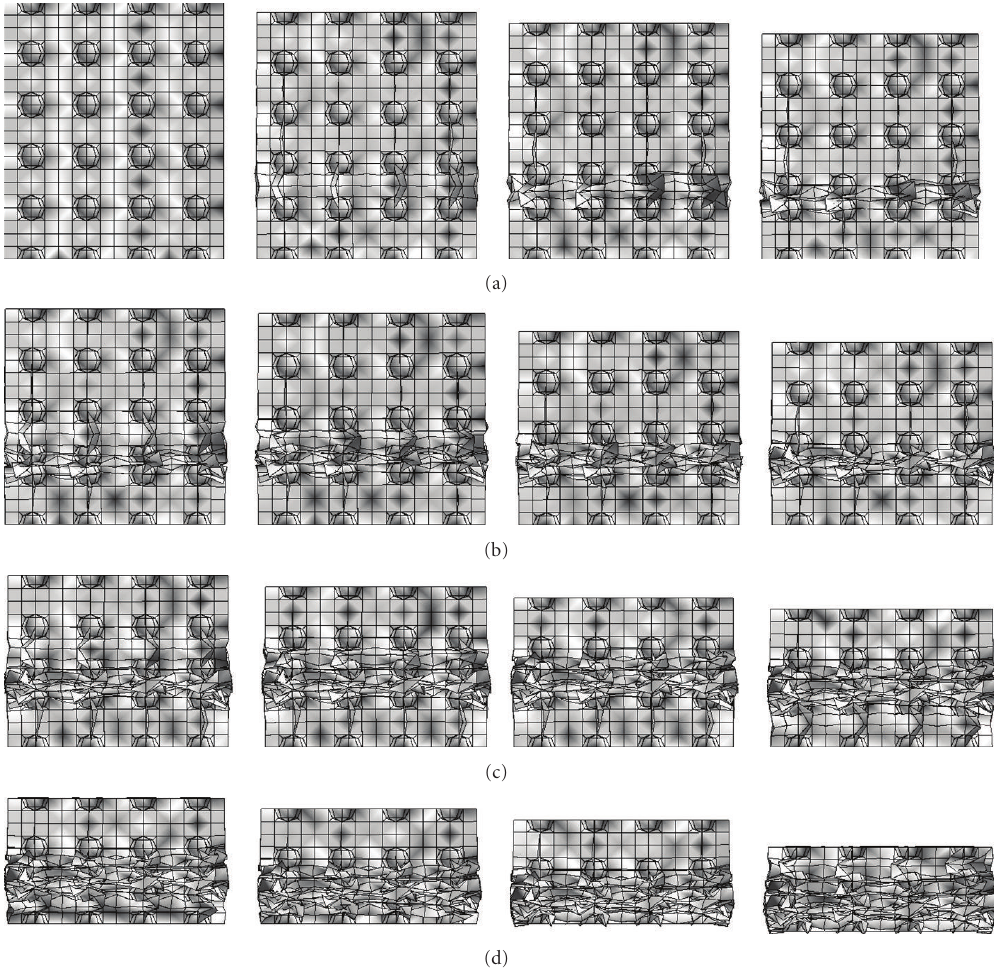
Figure 11: Two-dimensional views of the model in case of deformation pattern-II: (Layerwise deformation) obtained from simulation when the Layerwise thickness variation of foam was implemented in the